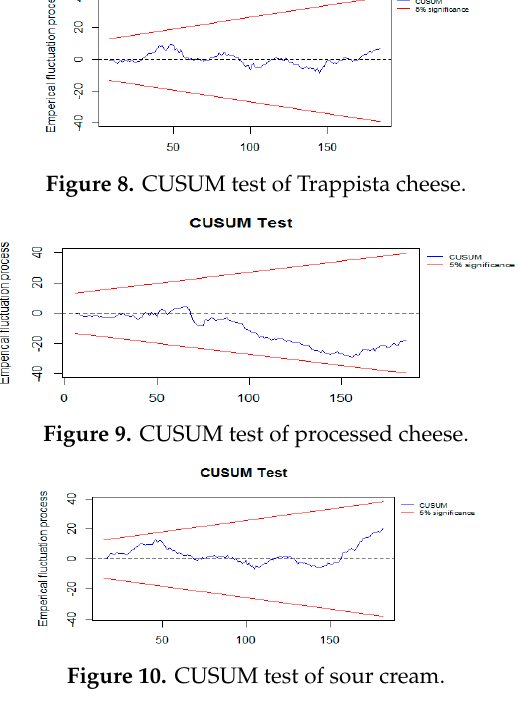
Figure 10. CUSUM test of sour cream.